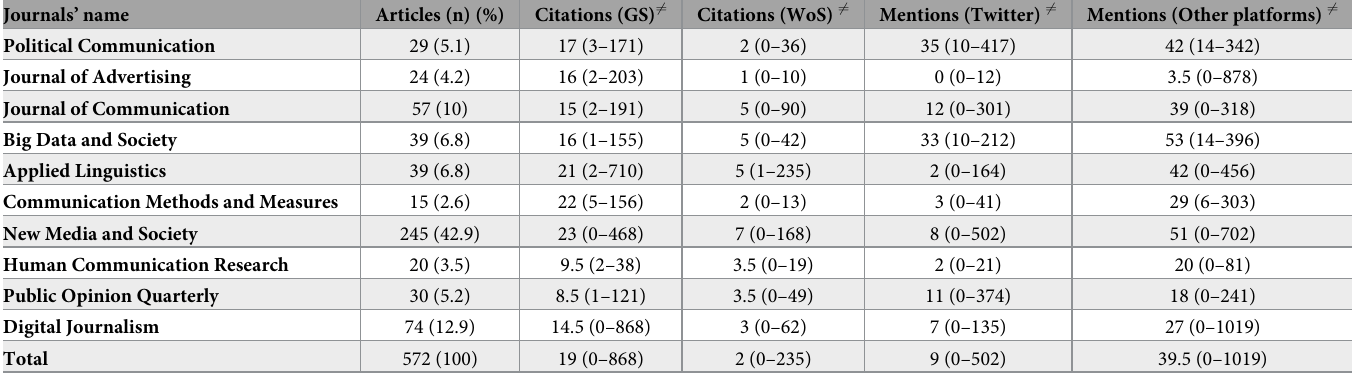
Table 2. The number of citations, mentions of Twitter and other platforms on the articles journal